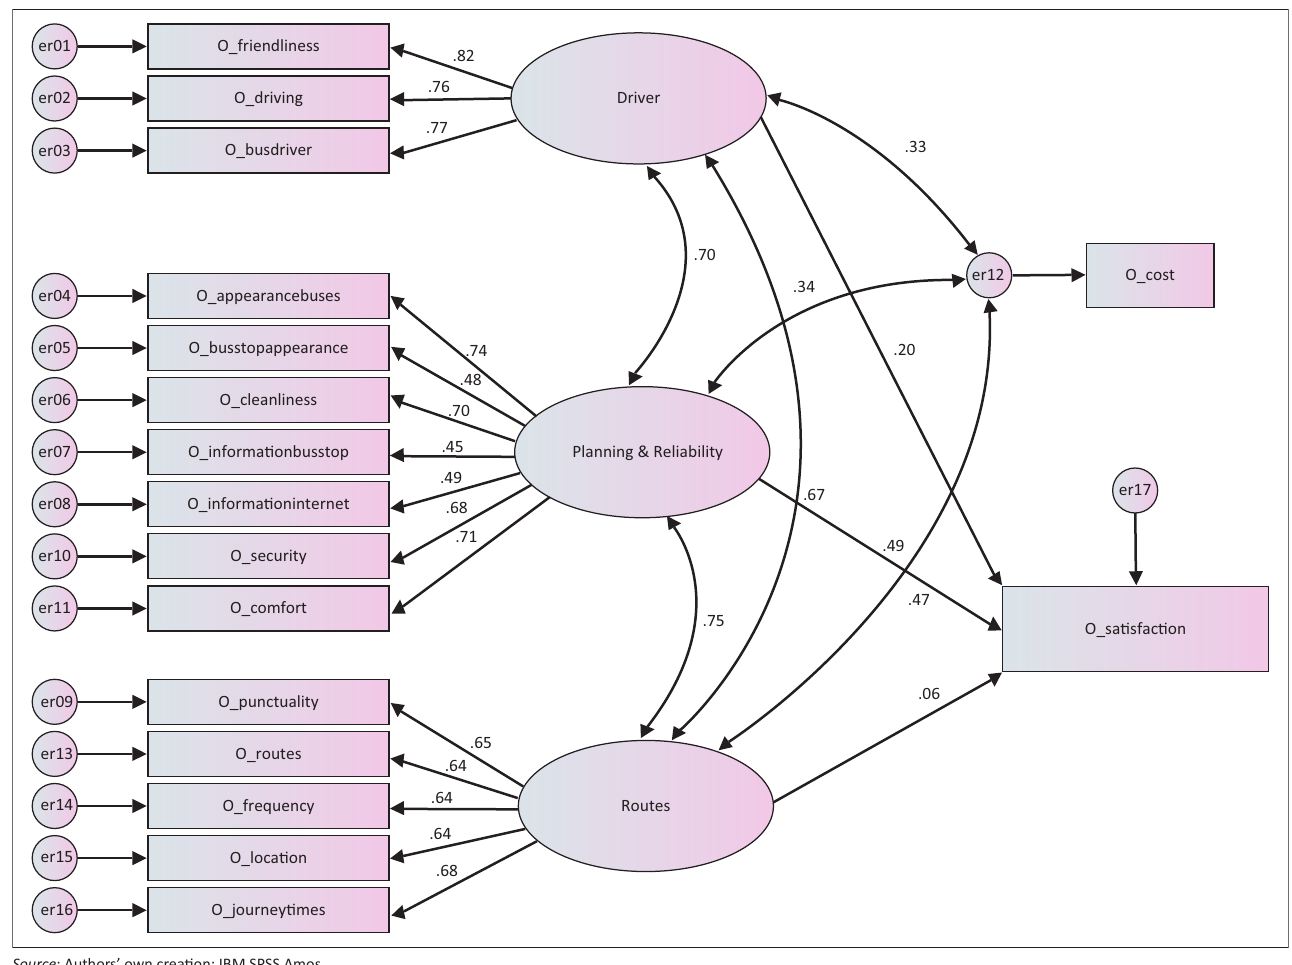
FIGURE 2: Final structural equation model (with standardised estimates). TABLE 8: Service quality areas of the final model. Service quality area